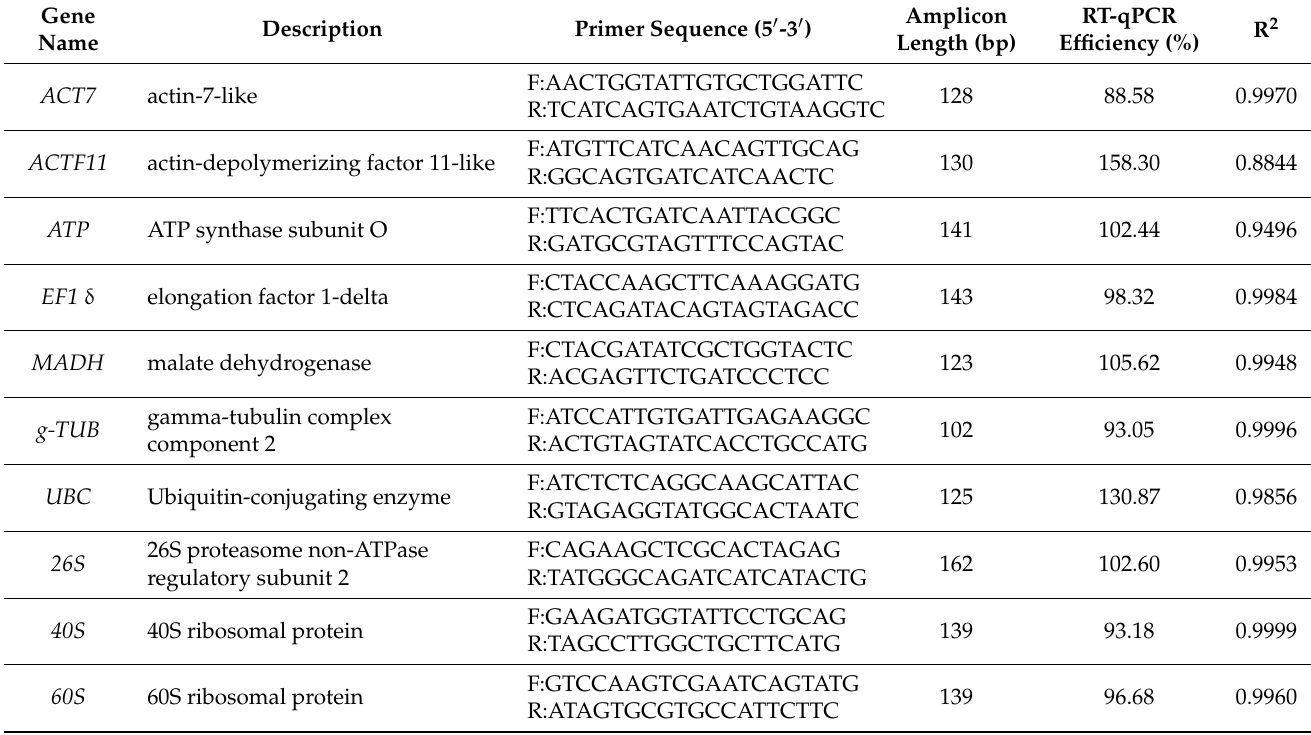
Table 1. Selected candidate reference genes, primers, and amplification